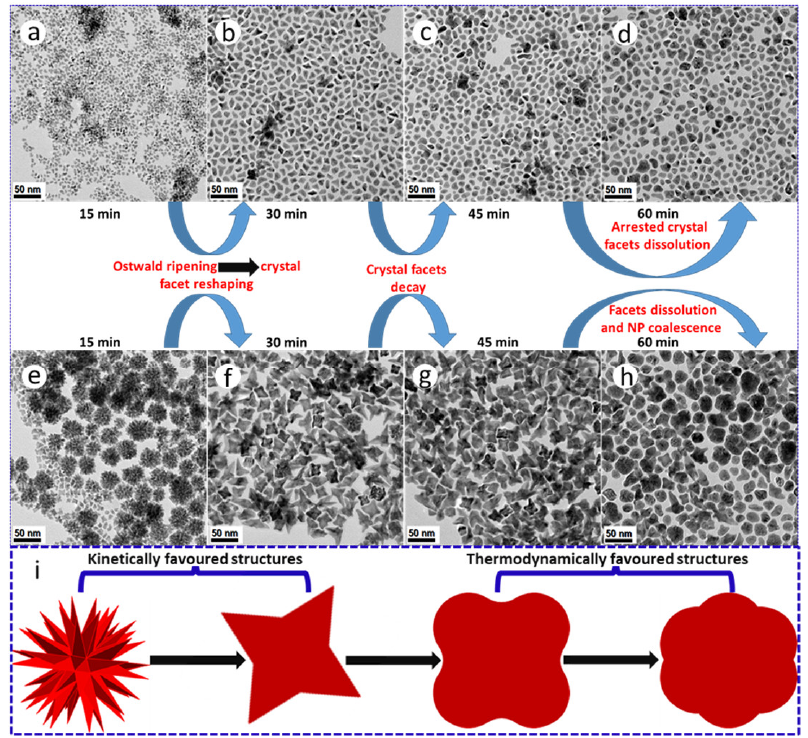
Figure 5. TEM BF images demonstrating the morphological transformations/changes of ( a – d ) PtNi and ( e – h ) Pt(NiCo) alloy NPs prepared by co-thermolytic decomposition of Pt and M (Ni and Co) acetylacetonate precursors. The colloidal alloy NP aliquots extracted from the bulk organic growth- mixture were sampled at different time intervals (from 15–60 min). ( i ) A corresponding schematic of geometrical restructuring from kinetically (high energy surface) to thermodynamically favourable (low energy surface) morphologies with extended ripening